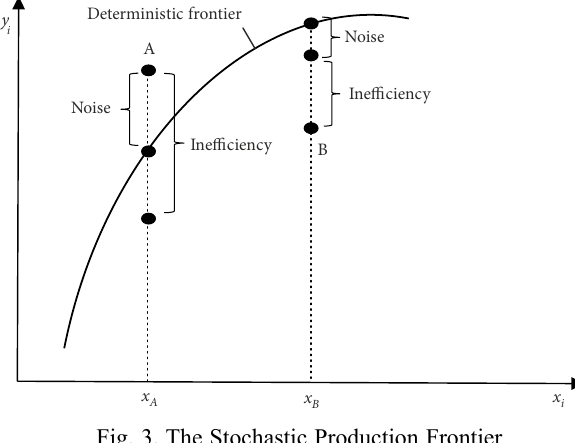
Fig. 3. The Stochastic Production Frontier Source : adapted from Fried et al.